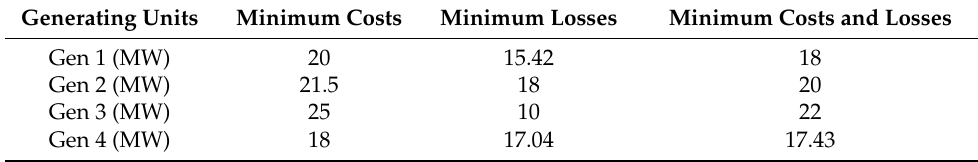
Table 4. Optimal solar PV power considering different objective functions for Garver system.